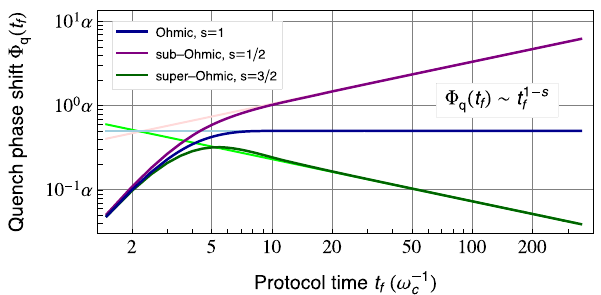
Fig. 2 Quench phase shift (QPS) Φ q ( t f ) of a sensor qubit coupled to a Gaussian quantum environment, acquired during a Hahn-echo sequence, as a function of protocol time t f . We assume the environment has spectral function which behaves as a power law at low frequencies, i.e., (cid:1) (cid:3) s e (cid:2) ω = ω ð Þ 2 . Curves correspond to different power J ½ ω (cid:5) ¼ ð α = π Þ ω ω = ω c c c laws: Ohmic ( s = 1, dark blue curve), sub-Ohmic ( s = 1/2, purple curve), and super-Ohmic ( s = 3/2, dark green curve). We see that the QPS is extremely sensitive to the spectral function power law s . Light-colored lines depict the asymptotic long-time dependence of the QPS Φ q ð t f Þ (cid:7) t 1 (cid:2) s f (see also Eq. (29)), which shows excellent agreement with the exact results in the long-time regime t f (cid:8) ω (cid:2) 1 , as expected. Note that for Gaussian, c bosonic environments, the QPS is independent of temperature.